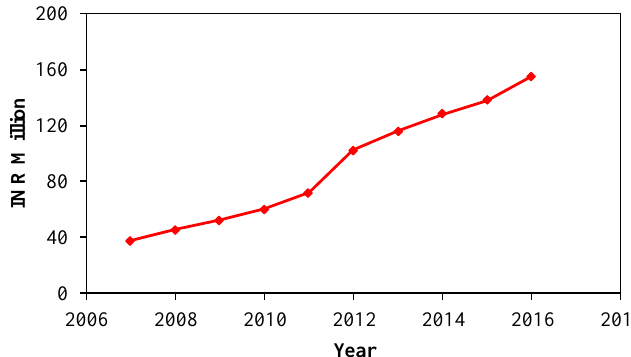
Figure 2. Disposable income growth in India over the last ten years (INR* Indian